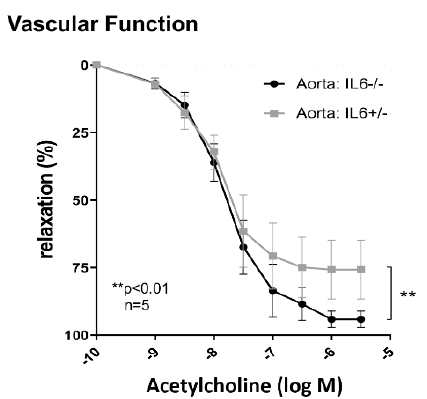
Figure 5. Effect of IL-6 on vascular function in mouse aorta. Thoracic aortic segments were isolated from 3-mo old male Il6 +/ − and Il6 − / − mice. The rings were contracted with noradrenaline and then relaxed with increasing concentrations of acetylcholine, n = 5. Values are means ± SEM. Statistical analysis was performed using two-way ANOVA.